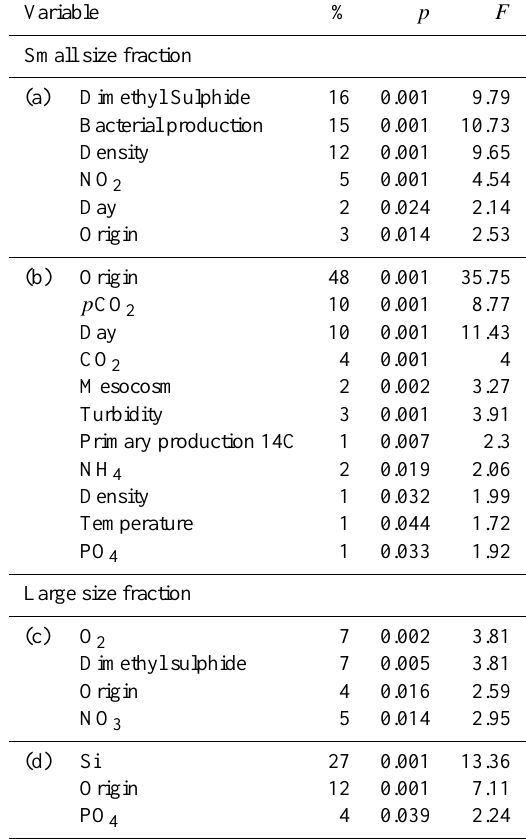
Table 2. Results from RDA forward selection (with Monte Carlo permutation tests) showing only the significant ( p < 0 . 05) struc- turing variables for the small (0.2–3µm) and the large (3–12µm) size fraction during the pre-nutrient period from t 1 to t 12 (a and c, respectively) and post-nutrient period from t 13 to t 30 (b and d,